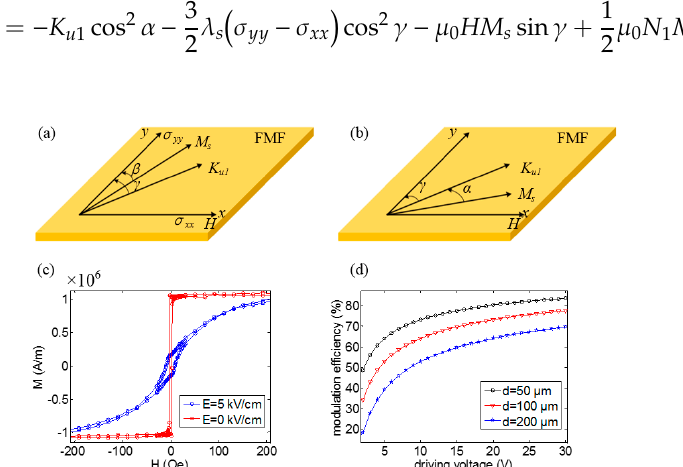
Figure 3. ( a ) The modulation efficiency as a function of the magnetic susceptibility modulation ability of FMF, M.; ( b ) the grow rate of the modulation efficiency as a function of the magnetic susceptibility modulation ability of FMF.